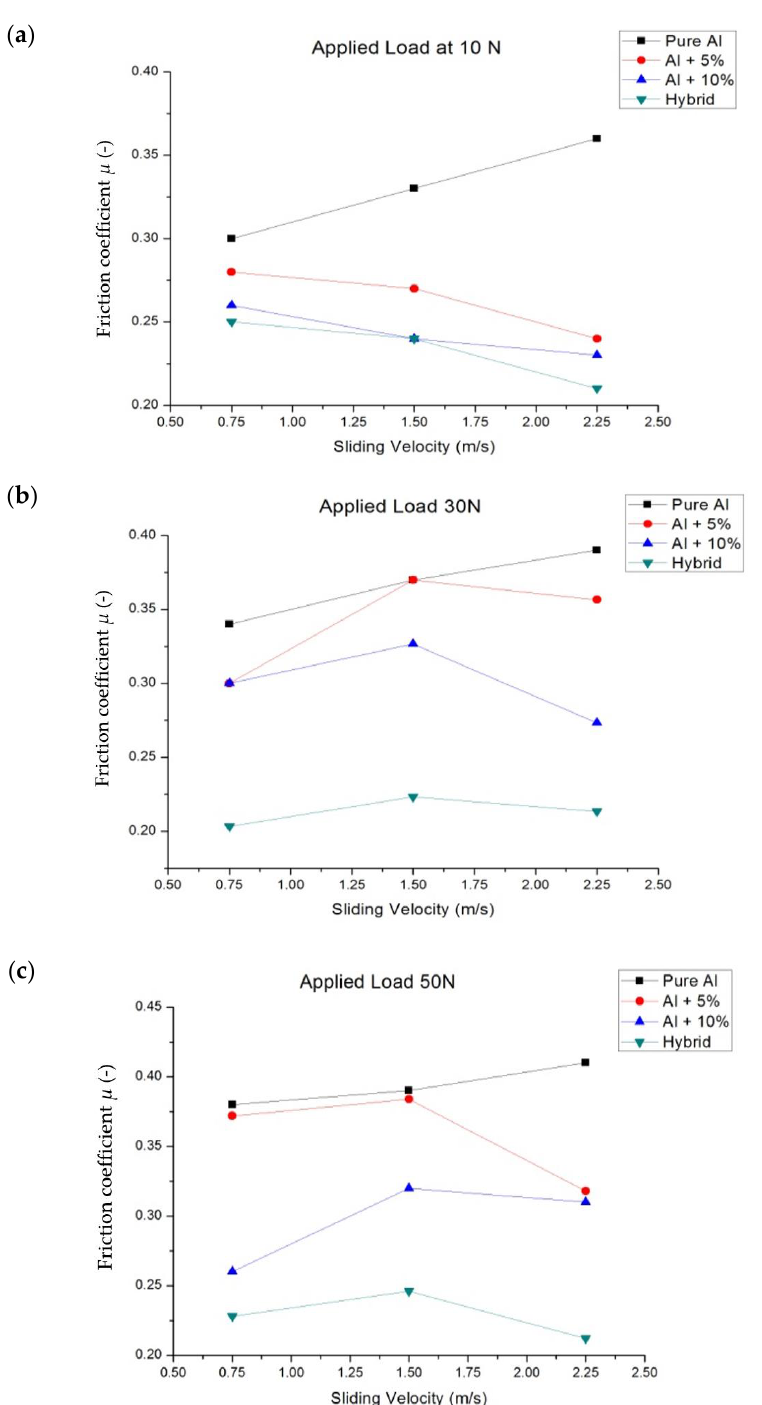
Figure 18. Friction coefficient: ( a ) 10 N ( b ) 30 N and ( c ) 50 N. It is worth noting that the friction coefficient of pure aluminium was higher than that for the primary reinforced and hybrid composites, which was attributed to the formation of an alumina oxide layer between the counter surface and pin material. During the wear process, the reinforced particulates that came out from the matrix material contained a rich amount of alumina oxide (Table 1). Moreover, the aluminium also reacted with oxy- gen at an elevated temperature to form alumina oxide. This formed a strong layer which was good enough to reduce the shearing action, but at higher load these oxide layers were torn out and the friction coefficient started to increase drastically. In the case of the hybrid specimen, the friction coefficient was slightly lower than the pure aluminium, 5 and 10 wt.% reinforced composites, and there might be two reasons for this. The first reason could be the formation of an alumina oxide layer along with the boron oxide layer. The secondary reinforcement removed from the pin material readily reacted with the environment to form boron oxide, and the oxides layer formed between the counter surface and pin material influenced its friction coefficient. The second reason could be the effect of porosity of the composites. At the 5 and 10 wt.%, the primary rein- forced composites had more porosity than the hybrid composites. An increase in porosity also increased the friction coefficient. The average friction coefficient obtained by varying the load was 0.211, 0.2122, 0.214, respectively. That result was in agreement with the re- sults obtained by Mazaheri et al. [46] but the friction coefficient was 0.340 for the hybrid composite and was approximately two times higher. At a sliding velocity of 1.5 mm/s and higher load of 30 N and 50 N, the stable oxide layer formed during the wear process was broken and the reinforcement particulate pull- out was reported in SEM, leading to the increase in the friction coefficient equal to that of 0.75 mm/s. However, at a low load of 10N, the friction coefficient decreased as the sliding velocity increased . However, in some cases the temperature difference was more or less constant for the primary reinforced composites due to the existence of the mechanically mixed layer and small amount of porosity. The existence of porosity failed to transfer the temperature to the counter surface or pin material completely. In the case of the hybrid composites, the rise in temperature was less when compared to the primary reinforced specimen. Alt- hough the porosity in the specimen (hybrid) was less than the unreinforced and primary reinforced composites, there should be an increase in the friction coefficient. That the strong oxide layer, due to the alumina oxide and boron carbide, took a longer time to wear the oxide layer could be the reason for the reduction in the friction coefficient.